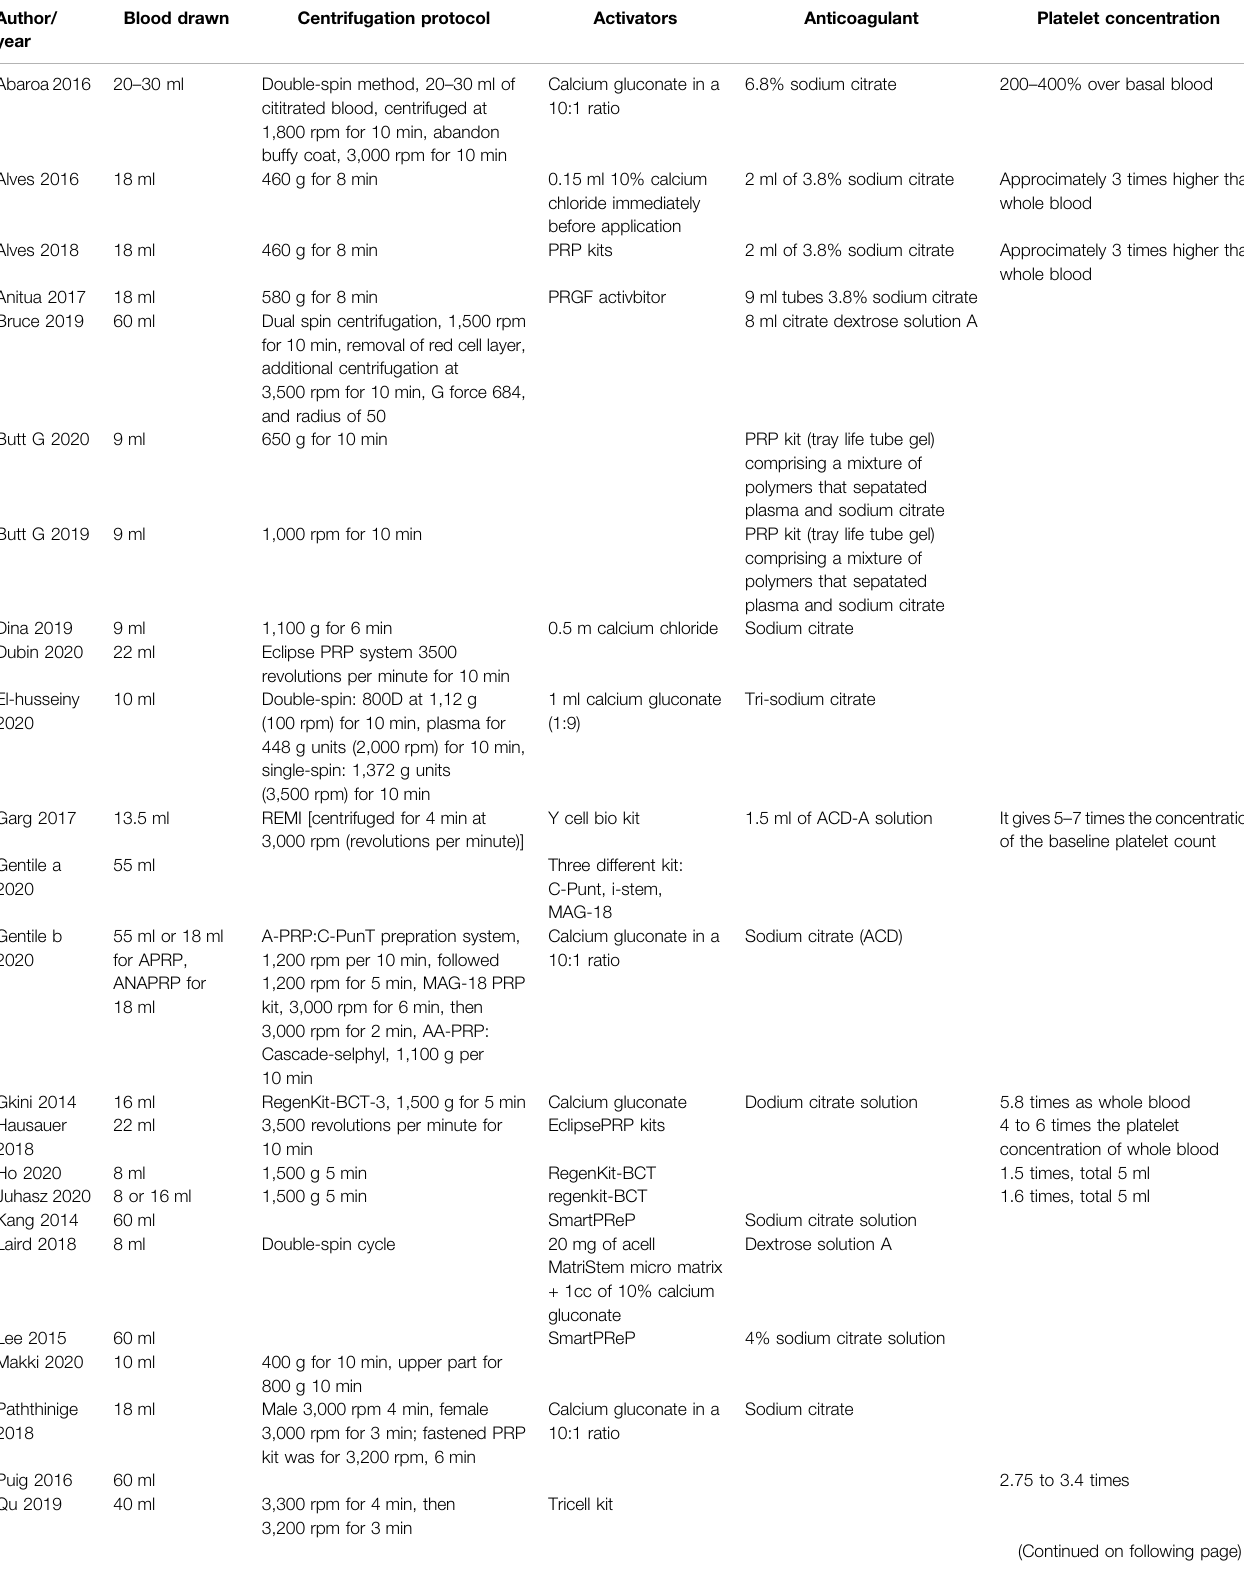
TABLE 2 | Preparation of PRP in